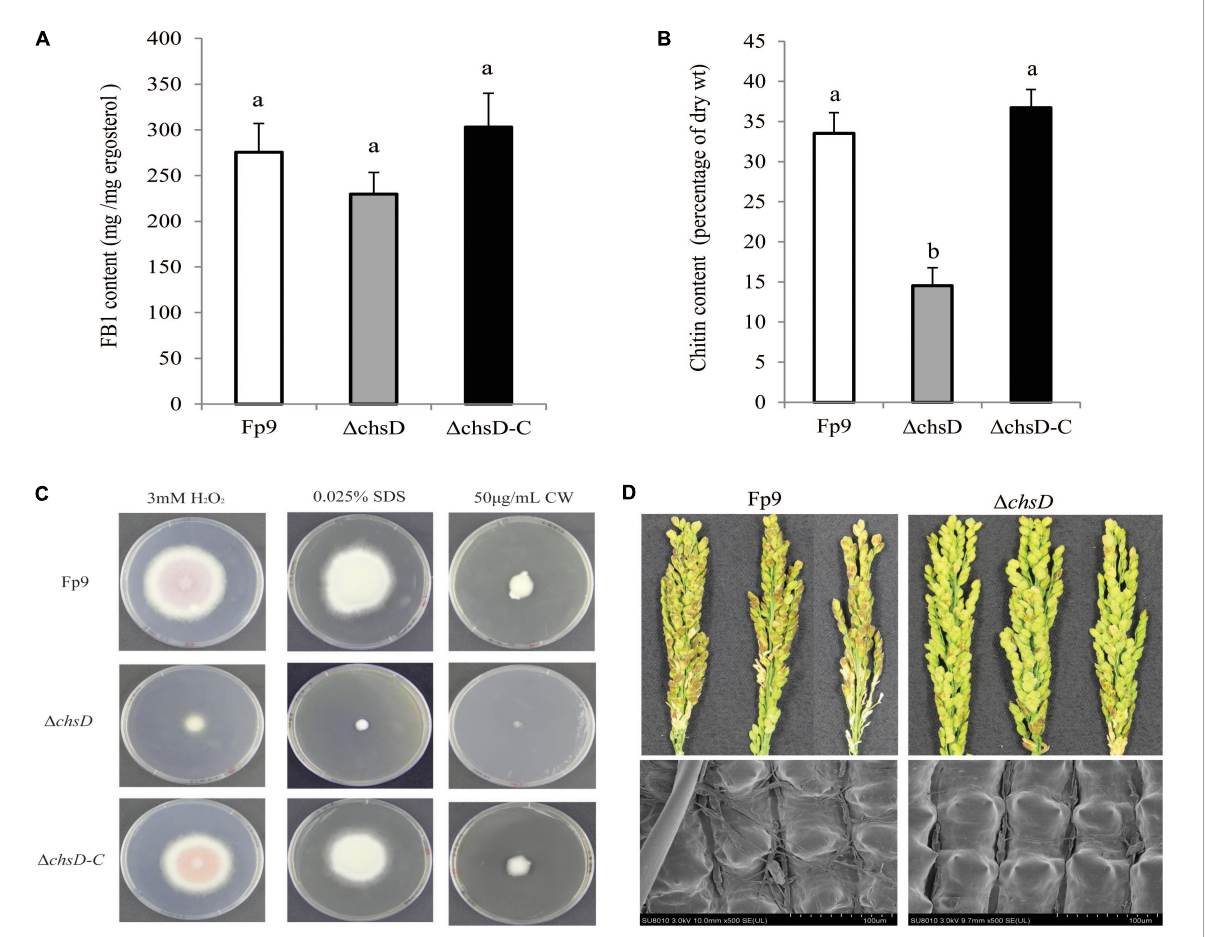
FIGURE6 Defects of (cid:49) chsD mutant in response to cell wall stress and virulence. (A) FB1 production of (cid:49) chsD mutant cultured with 15-day-old rice kernels. (B) Chitin content of vegetative hyphae of (cid:49) chsD harvested from 5-day-old PDA cultures. Different letters on bars indicated a significant difference ( p < 0.05) with three biological replicates. (C) Sensitivity to cell wall perturbing agents of (cid:49) chsD on PDA media with 3 mM